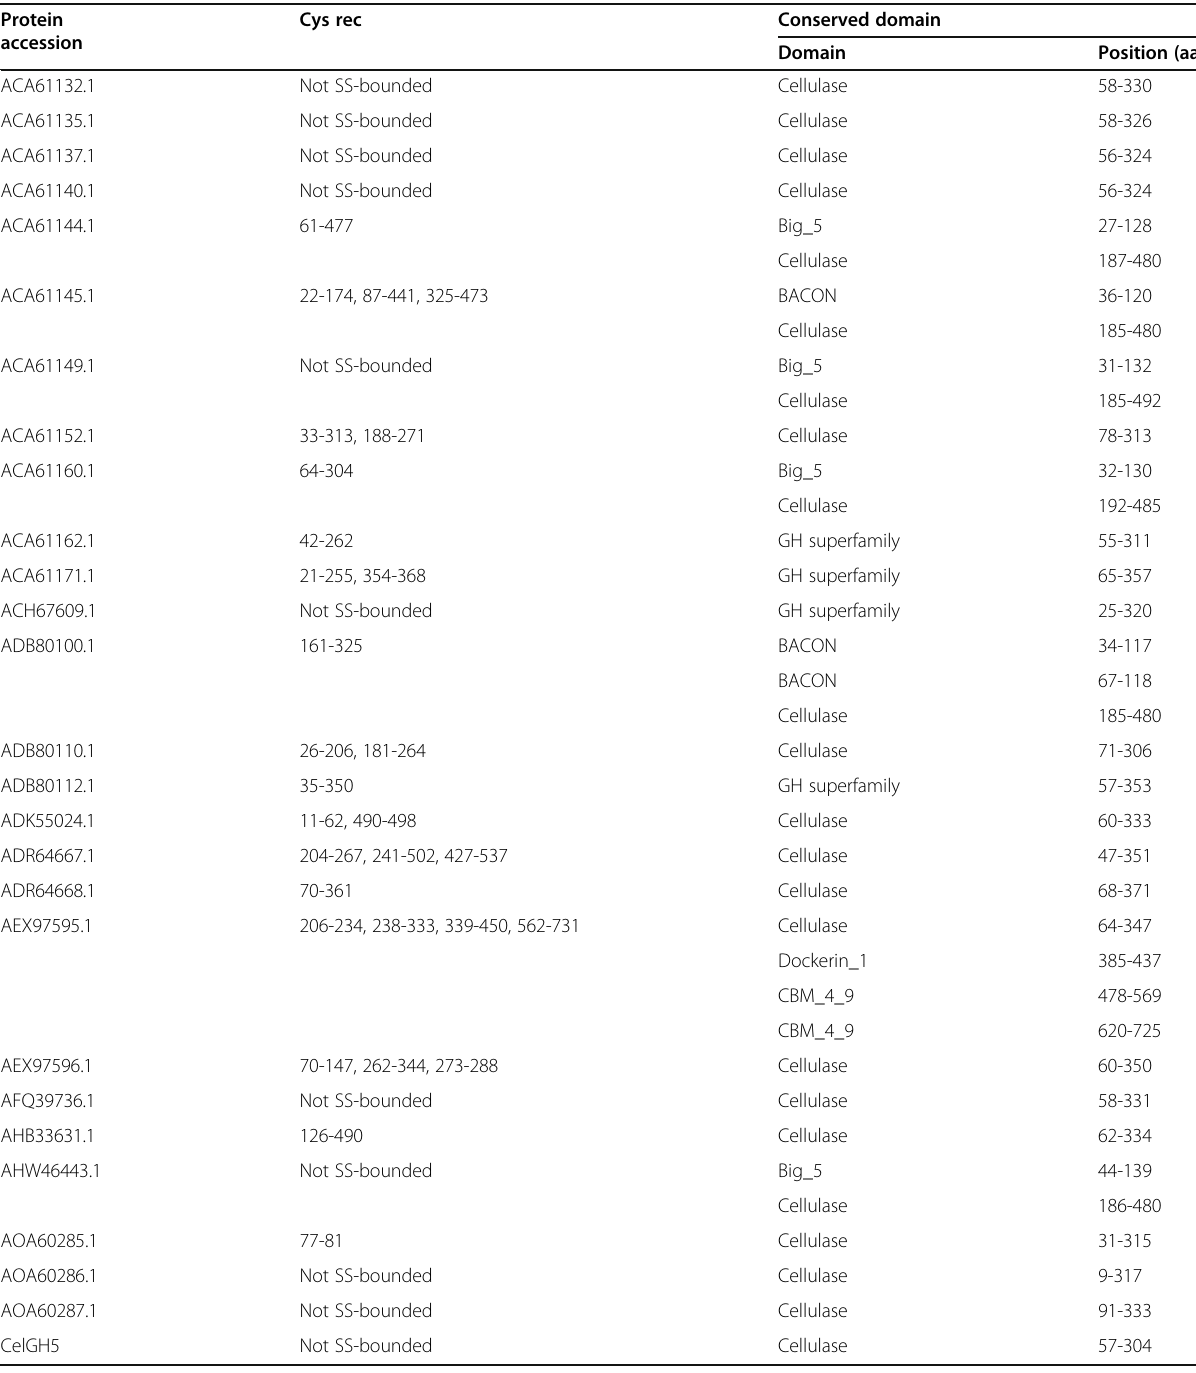
Table 6 Disulfide bond prediction and conserved domain identification Protein